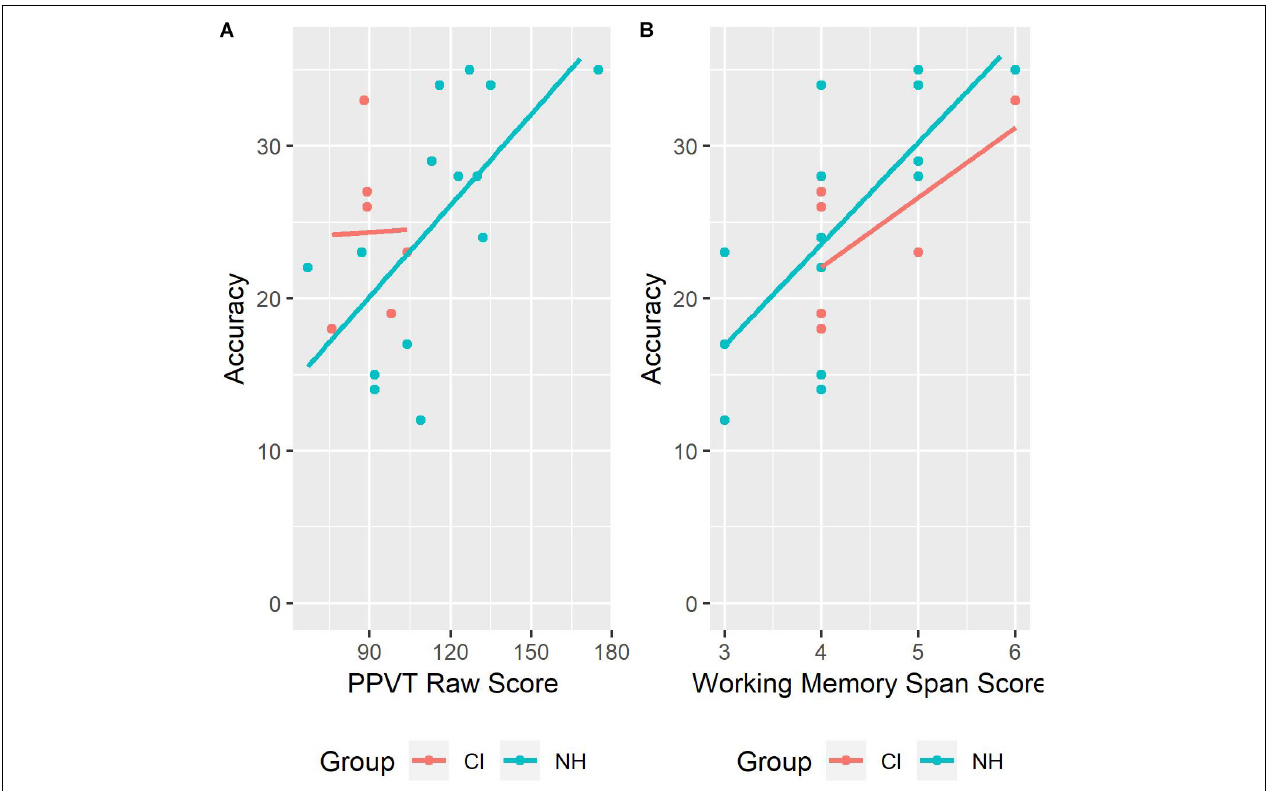
FIGURE 1 | Rhyme oddity task performance as a function of vocabulary (A) and working memory (B) .